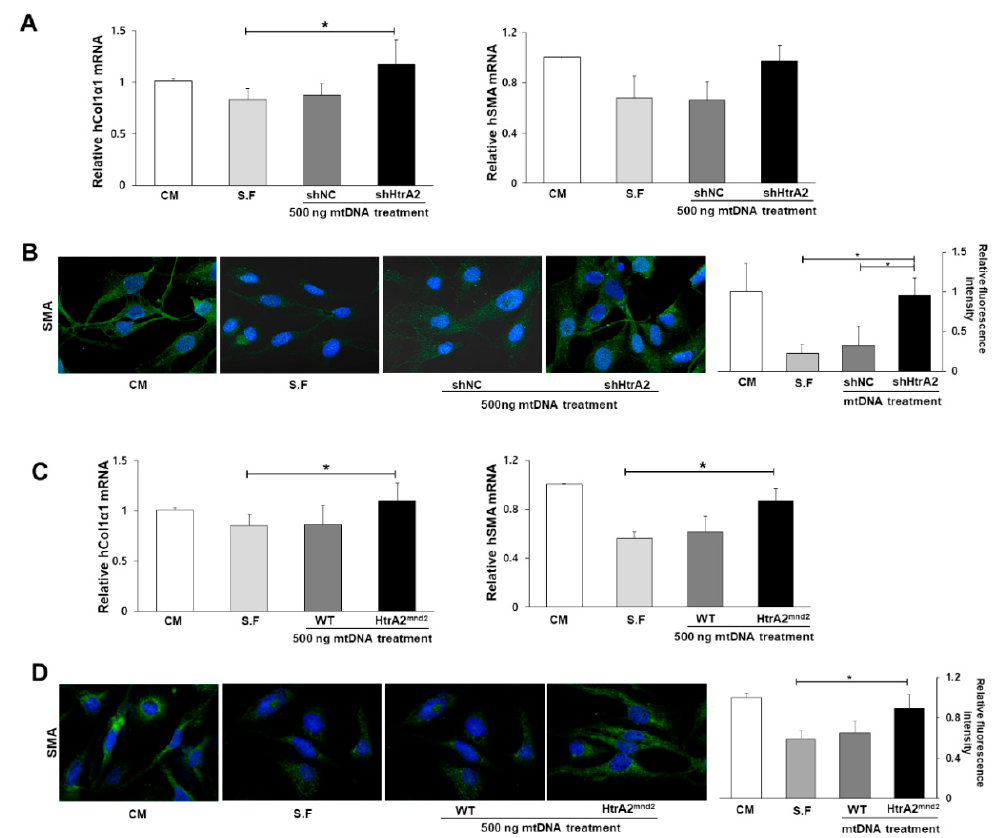
Figure 5. Loss of HtrA2 / Omi mitochondrial protease activity promotes liver fibrosis. ( A , C ) Collagen 1 and α -SMA mRNA expression in LX-2 cell treated with the same concentration (500 ng) of hepatocyte derived-mtDNA, as determined by qRT-PCR. ( B , D ) Immunofluorescence staining for α -SMA (green) performed in LX-2 cell treated with hepatocyte derived-mtDNA. Nuclei were stained with DAPI (blue). The relative intensity measurement of immunofluorescence is shown as histogram for α -SMA. Original magnification, X400. CM: cultured LX-2 cells in completed media condition; S.F.: cultured LX-2 cells in serum free media condition.